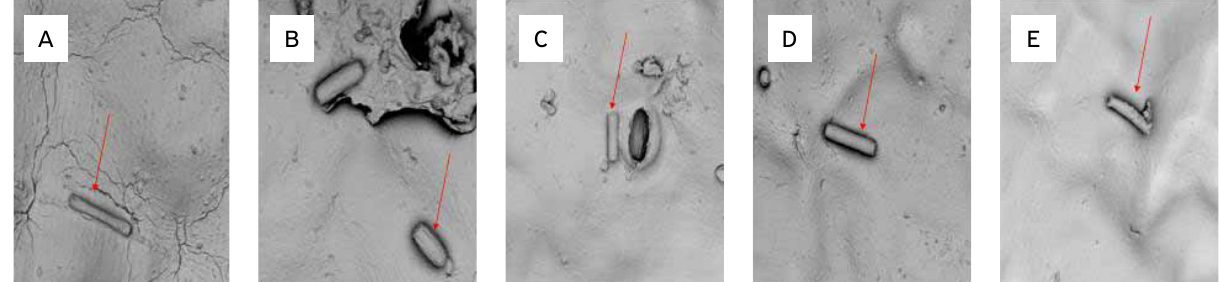
Figure 3. Spores of isolates from cacao (A), mango (B), atemoya (C), eucalyptus (D) and teak (E) on the surface of passion fruits at 96 hours